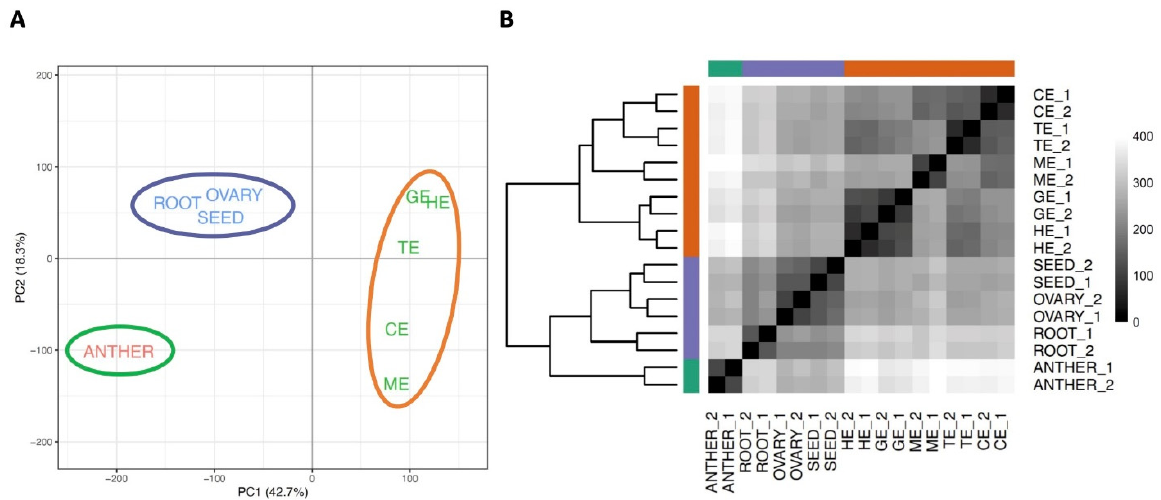
Figure 1. Relationship of the transcriptomes in different tissues and stages during embryonic devel- opment in flax. ( A ) Principal component analysis (PCA) using expressed genes in 9 tissues/stages in flax. X -axis, PC1; Y -axis, PC2. The proportion of variance for each principal component is indicated in brackets of axis titles. Three separated groups are labeled with different colors and in different ovals. GE, globular embryo; HE, heart embryo; TE, torpedo embryo; CE; cotyledon embryo; ME, mature embryo. ( B ) Heatmap of sample distance from different tissues/stages with two replicates (numbered 1 and 2). The grayscale spectrum represents sample distance calculated by R dist function ranging from 0 (black) to 400 (white), indicating high to low correlations, respectively. The hierarchical tree generated using expressed genes in each sample is shown on the left of the heatmap.